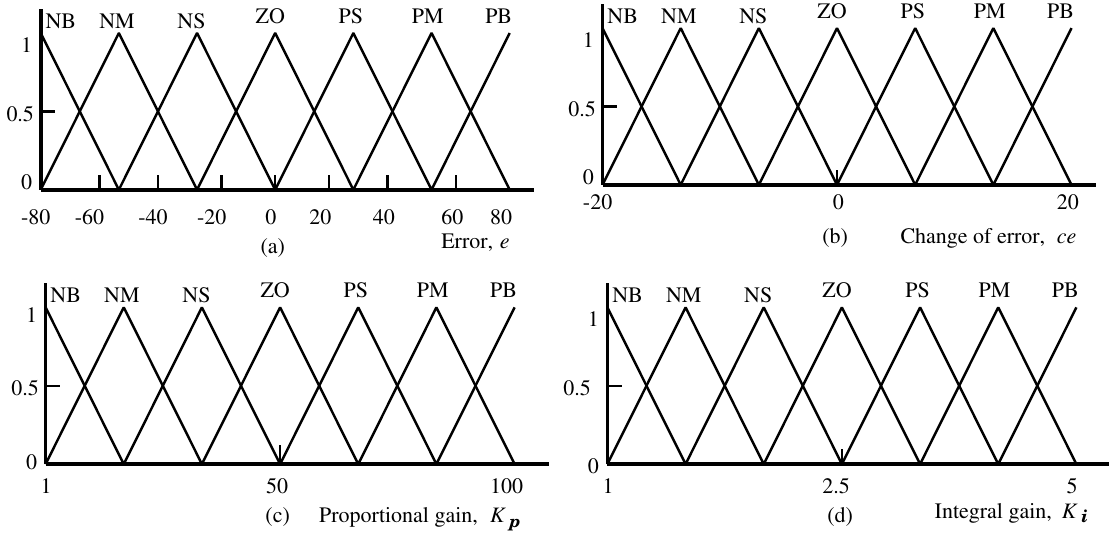
( d ) output members, integral p